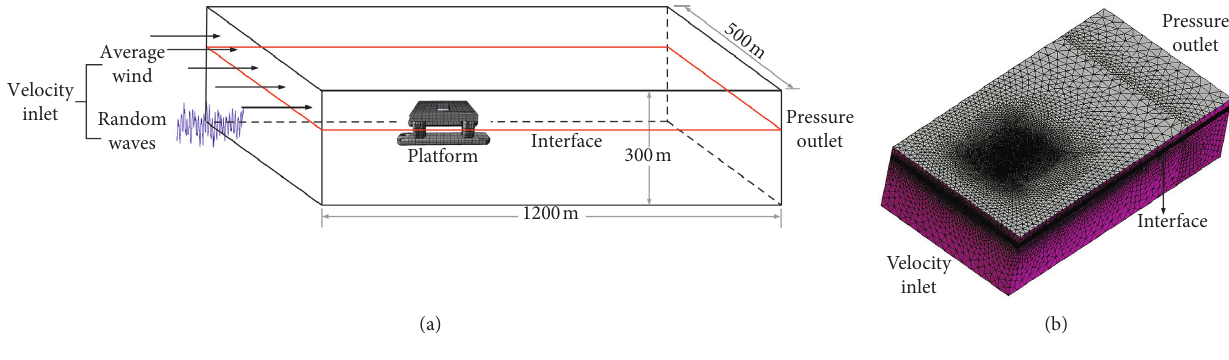
Figure 5: (a) A sketch of the 3D computational fluid domain. (b) Full grid domain.